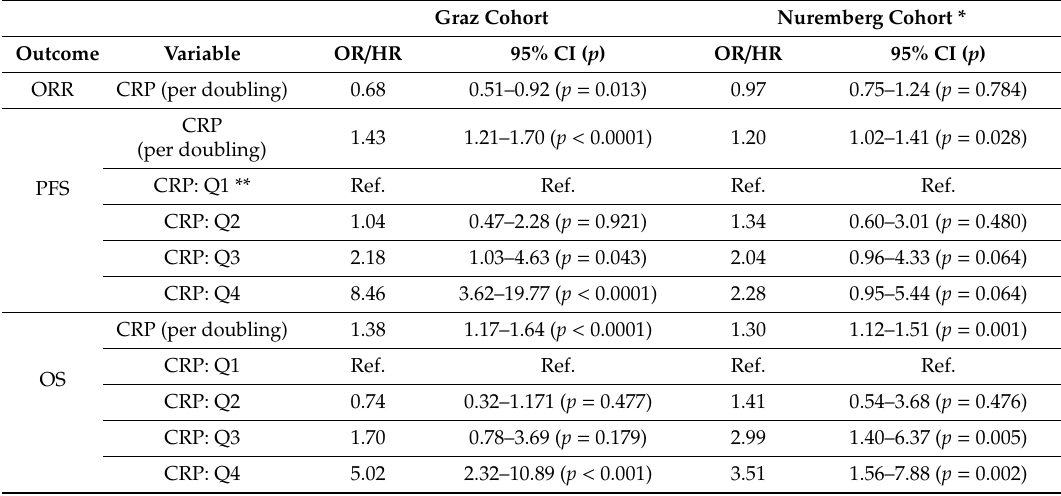
Table 3. Prognostic associations between baseline CRP and clinical outcomes of ICI therapy in the Graz cohort (development cohort) and Nuremberg cohorts (external validation cohort).